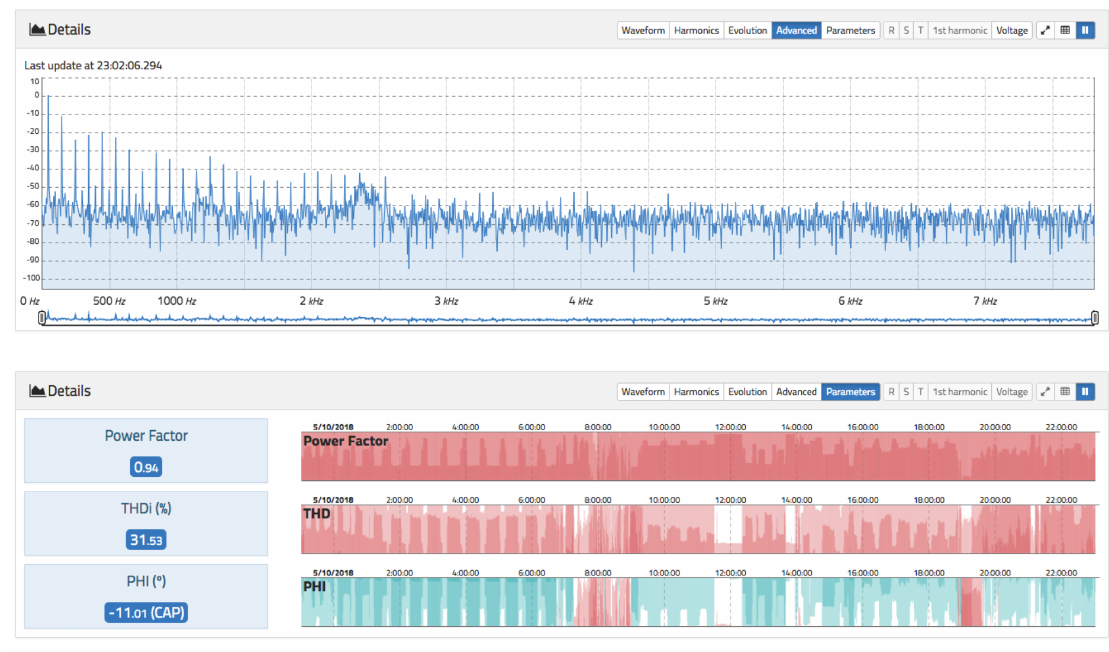
Figure 12. Top: current spectrum. Bottom: advanced parameters THDi, power factor, and phase angle for